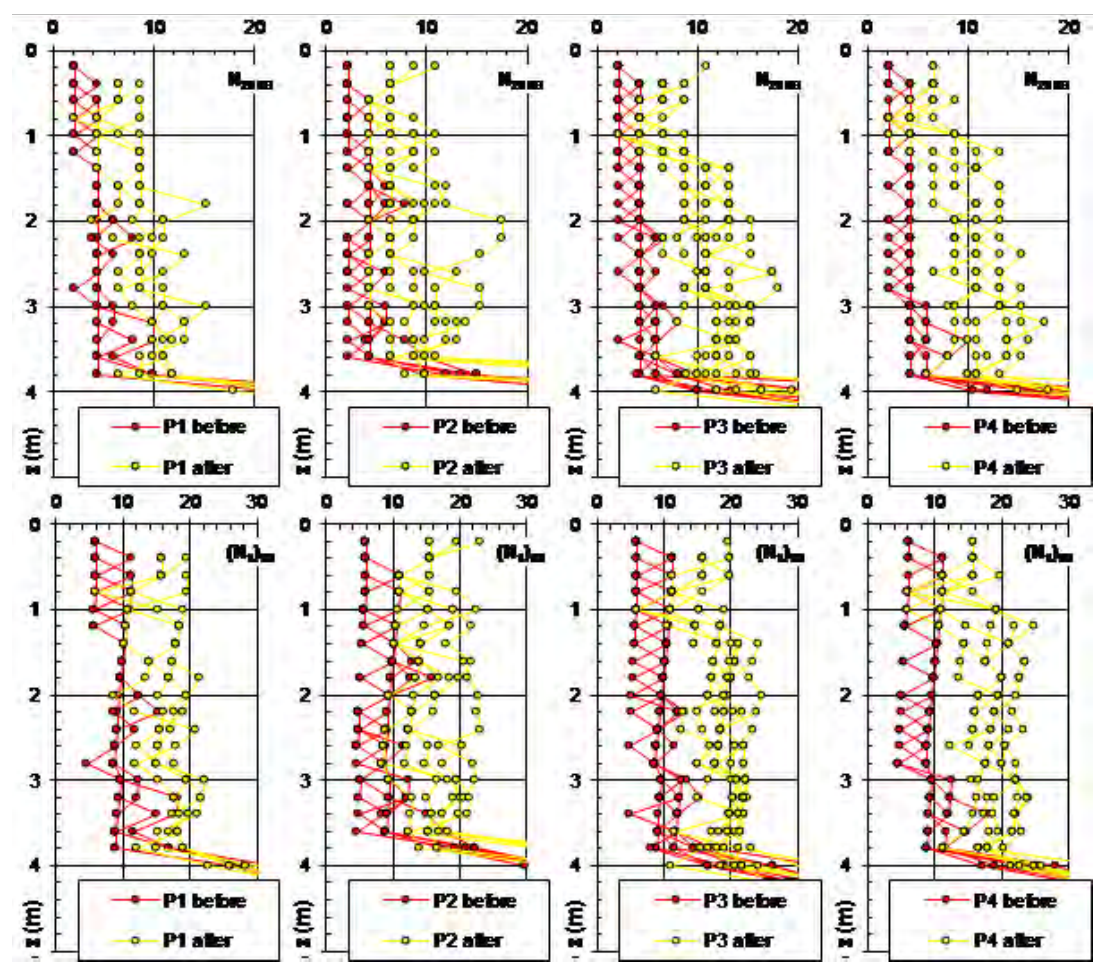
Figure 19. Comparison of N 20 SB and calculated ( N 1 ) 60 values before and after compaction (tests per- formed by IRGO,